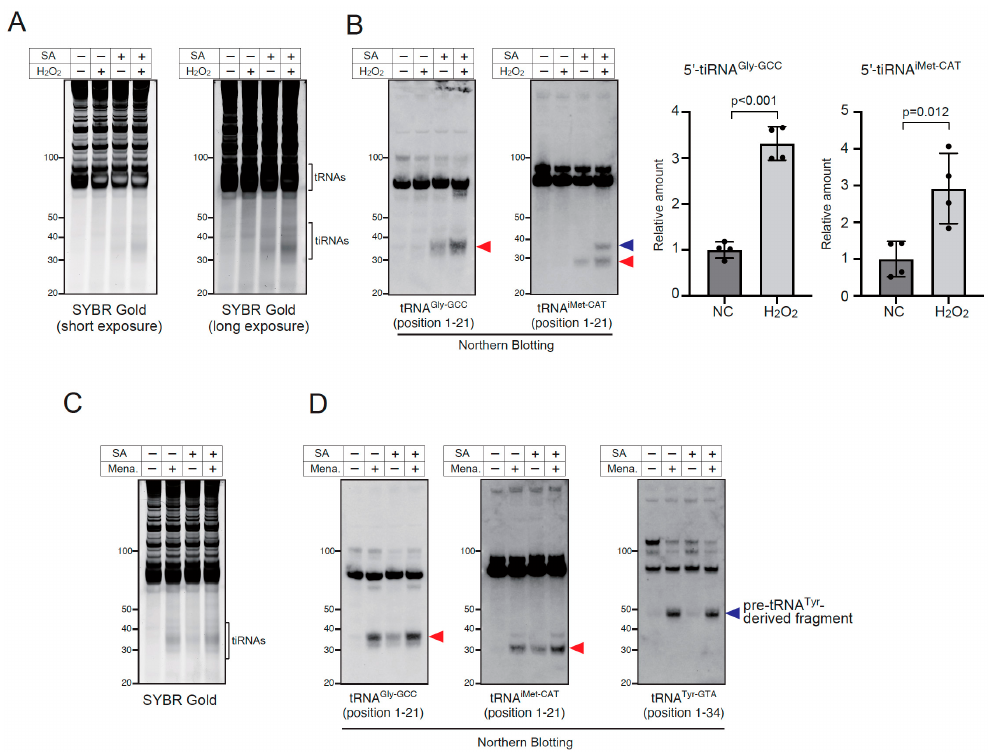
Figure 4. Oxidative stress boosts tiRNA production through inhibition of the RTCB ligase complex. ( A , B ) H 2 O 2 treatment boosts sodium arsenite-induced tiRNA production. U2OS cells were treated with 500 µM of sodium arsenite and/or 1 mM of H 2 O 2 for 2 h. ( A ) SYBR Gold staining and ( B ) Northern blotting for tRNA Gly-GCC and tRNA iMet-CAT . Canonical 5 ′ -tiRNAs are indicated by arrowheads, while a non-canonical 5'-tiRNA iMet-CAT is indicated by a blue arrowhead. The amounts of 5 ′ -tiRNAs calculated by densitometry are also shown (n = 4 each). ( C , D ) Effect of the combination between menadione (at 100 µM) and sodium arsenite (at 500 µM) on tiRNA production. ( C ) SYBR Gold and ( D ) Northern blotting for tRNA Gly-GCC , tRNA iMet-CAT and tRNA Tyr-GTA . tiRNAs are indicated by red arrowheads. SA, sodium arsenite; Mena., menadione.